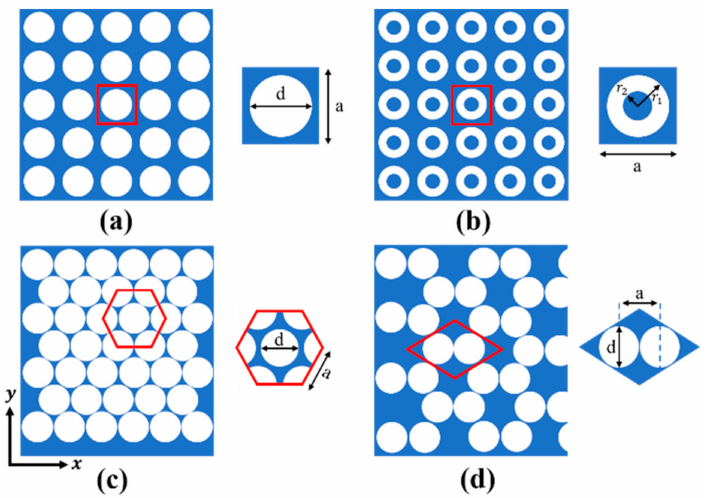
Figure 1. Phononic crystal structures of four different cell types: ( a ) square lattice, ( b ) square hollow cylinder lattice, ( c ) honeycomb lattice, ( d ) triangular